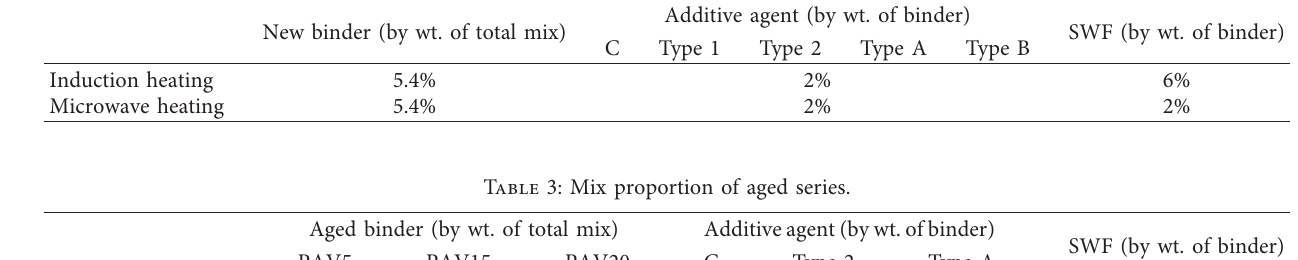
Table 2: Mix proportion of moisture damage series.